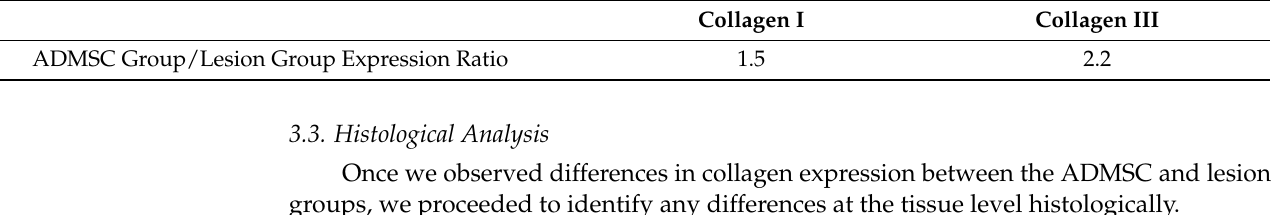
Figure 5. Mean fold gene expression % for collagen III relative to GAPDH in healthy, ADMSC, and lesion groups determined by quantitative RT-PCR. Standard error of the mean (SEM) is also depicted. * p < 0.05. Table 4. Gene expression ratios.